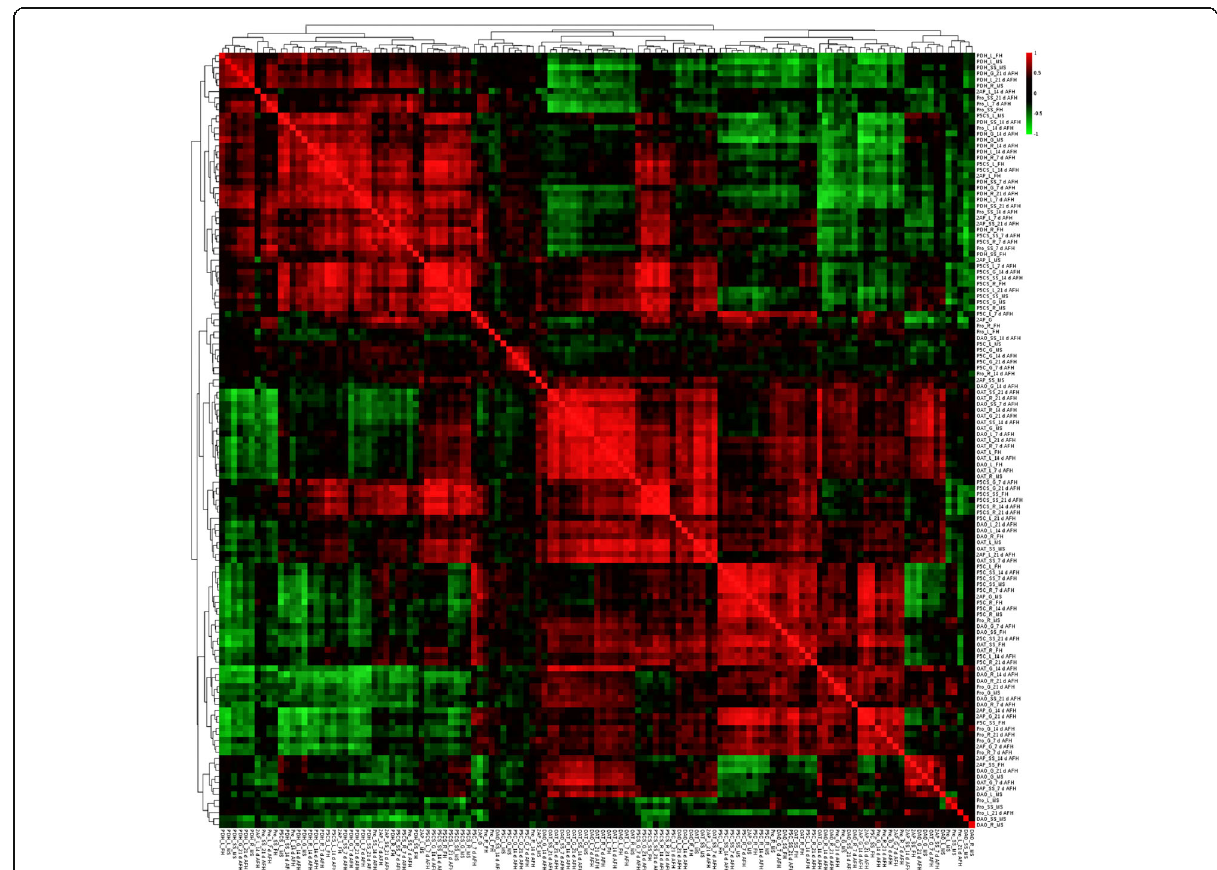
Fig. 3 The heatmap for the investigated parameters. 2AP: 2-acetyl-1-pyrroline, Pro: Proline, PDH: Proline dehydrogenase, P5CS: Pyrroline-5- carboxylic acid synthetase, OAT: Ornithine aminotransferase, P5C: 1-pyrroline-5-carboxylic acid, DAO: Diamine oxidase activity, FH: full